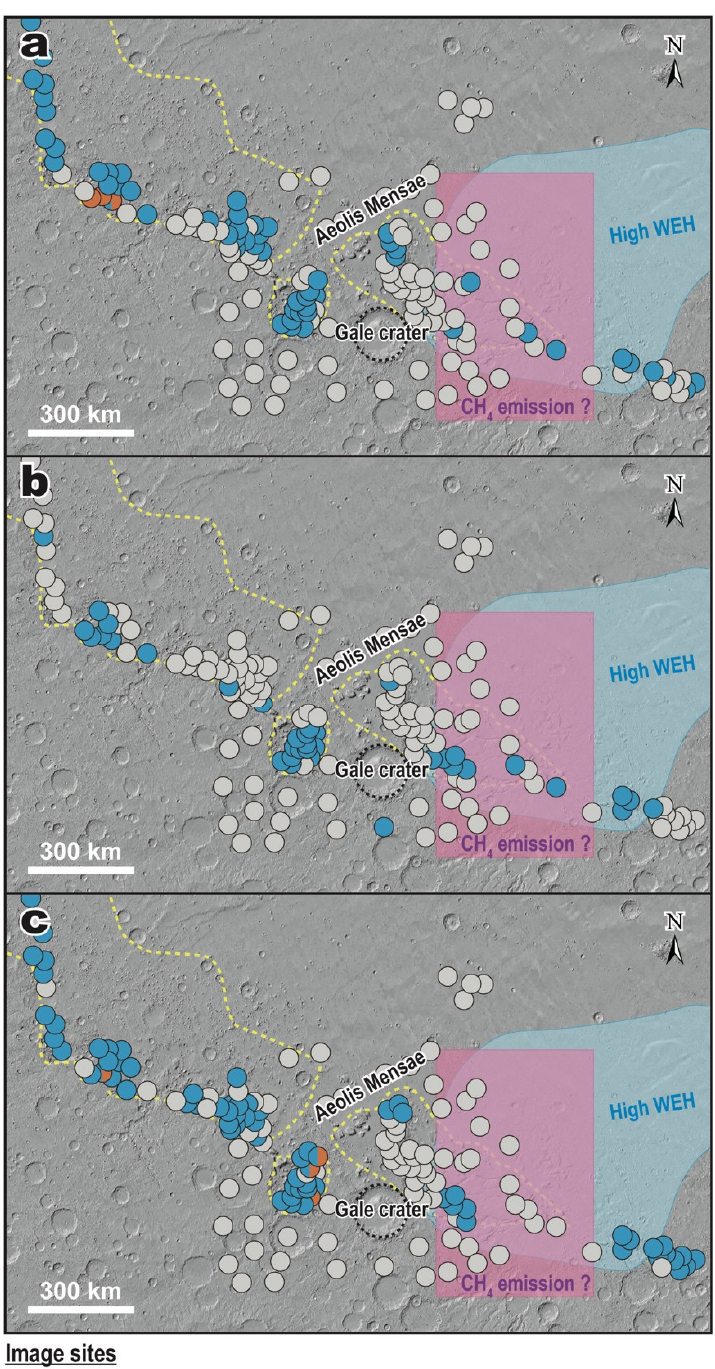
Figure 13. Classification results of chaos blocks (locations shown by circles) for the Aeolis Mensae and Nepenthes Mensae regions based on the ( a ) CTX, ( b ) THEMIS, and ( c ) MOLA classifiers. Regions surrounded by yellow dotted lines are chaos-like features. Blue and pink areas, respectively, represent the Medusae Fossae Formation (MFF), with high water equivalent height (WEH) contents [69], and regions that are likely sources of a CH 4 spike found in the Gale Crater, as suggested by the Global Circulation Model [70]. The black dotted circle represents the Gale Crater.